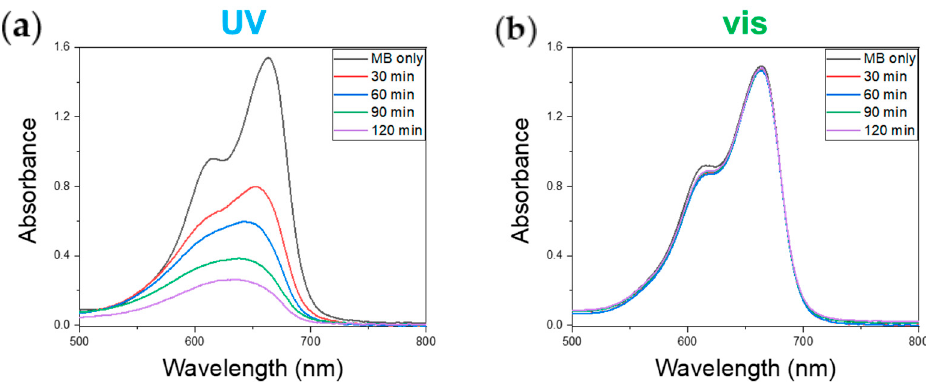
Figure 2. Photocatalytic degradation of MB with TiO 2 NPs under: ( a ) UV and ( b ) visible irradiation.